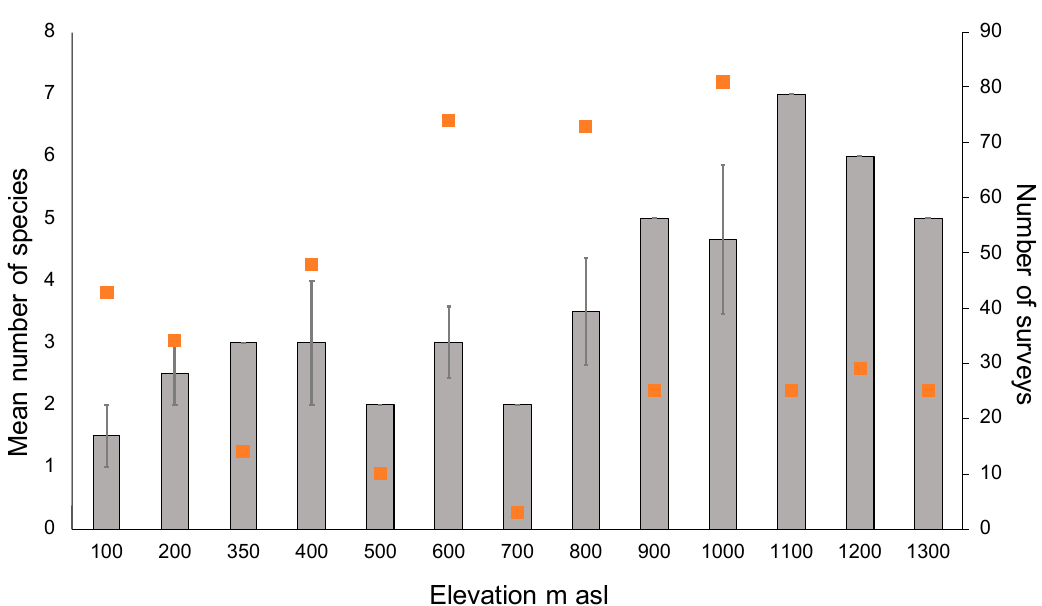
Figure 13. Diversity across elevation, pooling across five subregions. Mean number of Anonychomyrma species (±SE) per elevation as gray bars and number of surveys per elevation as orange symbols.